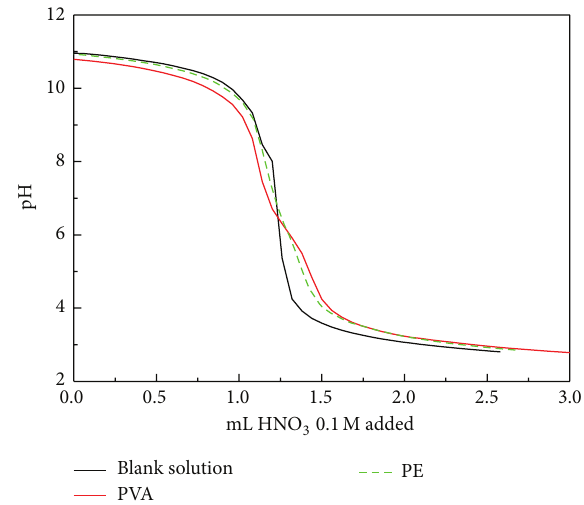
Figure 3: DR spectra of the biofilm formed on the surface of PVA support.